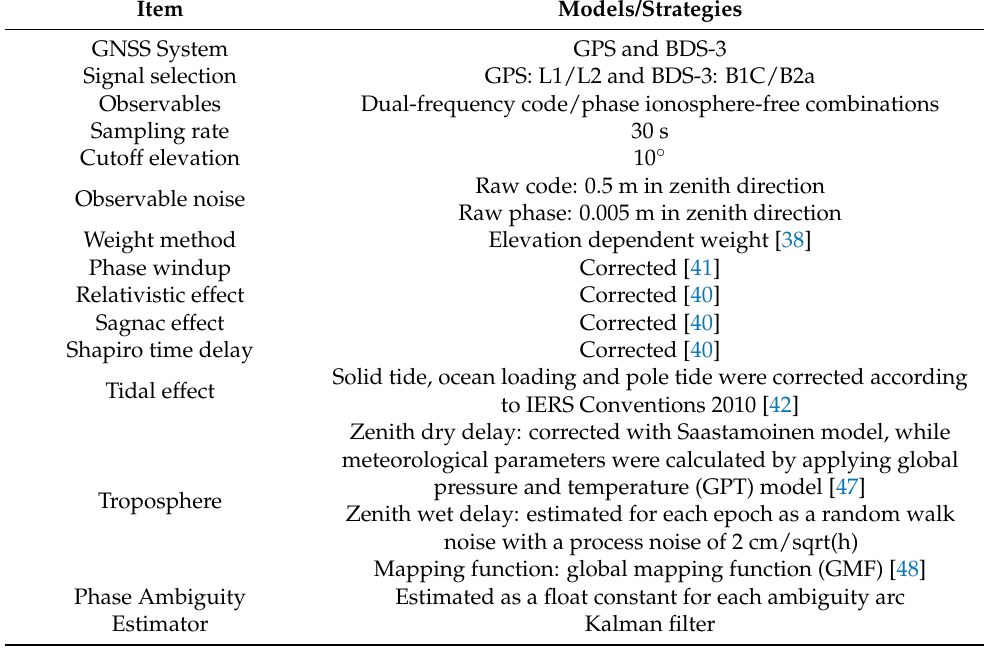
Figure 7. Location of 4 selected iGMAS stations. Table 4. Strategies of PPP